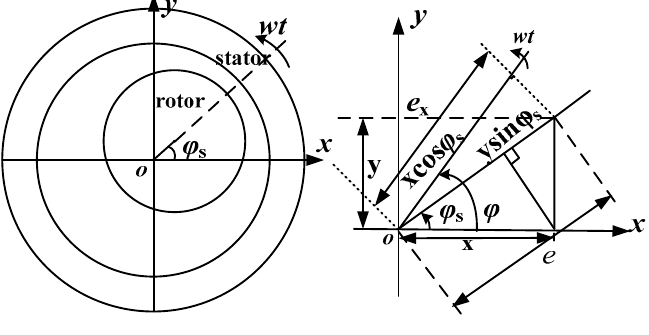
Figure 6. The definition of rotor eccentricity.